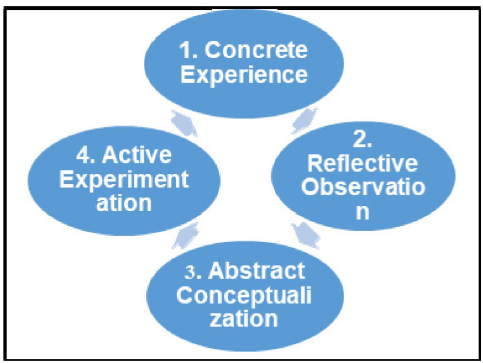
Figure 4. Adoption Experience Learning Cycle